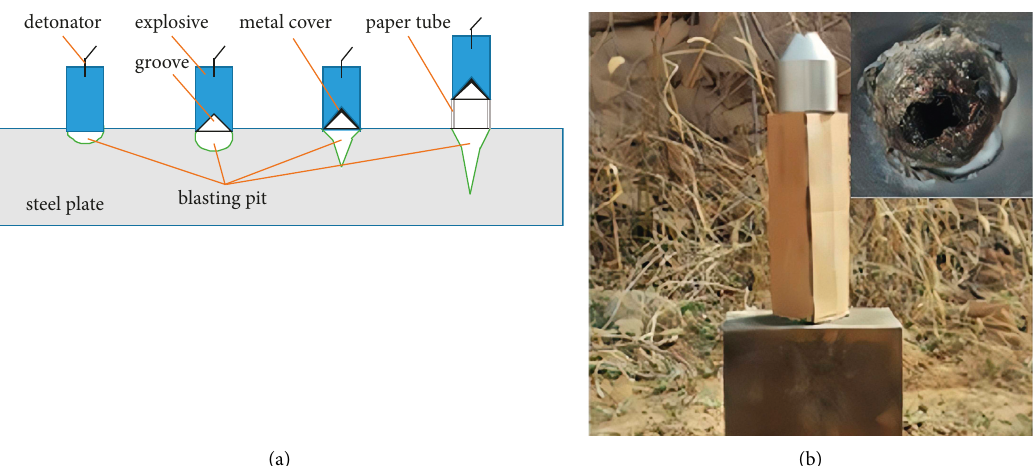
Figure 2: Schematic diagram of energy-concentrated effect. (a) Energy accumulation experiment. (b) Penetration test of steel plate [27,